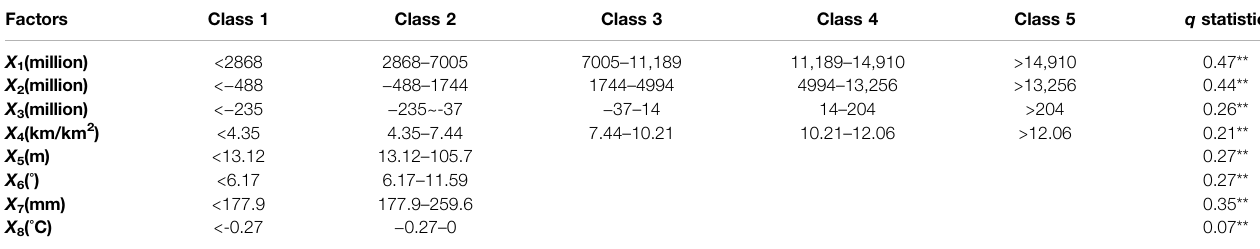
TABLE 3 | The in fl uencing factors and detection results of land-use change in Baiyun District, 2000-2020.